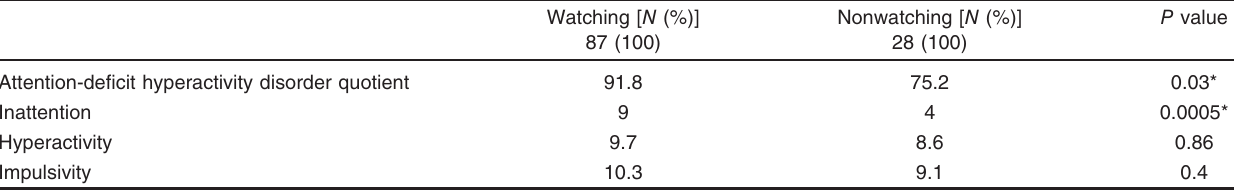
Table 3 Attention-deficit hyperactivity disorder quotient, inattention, hyperactivity, and impulsivity subscales in both watching and nonwatching television children